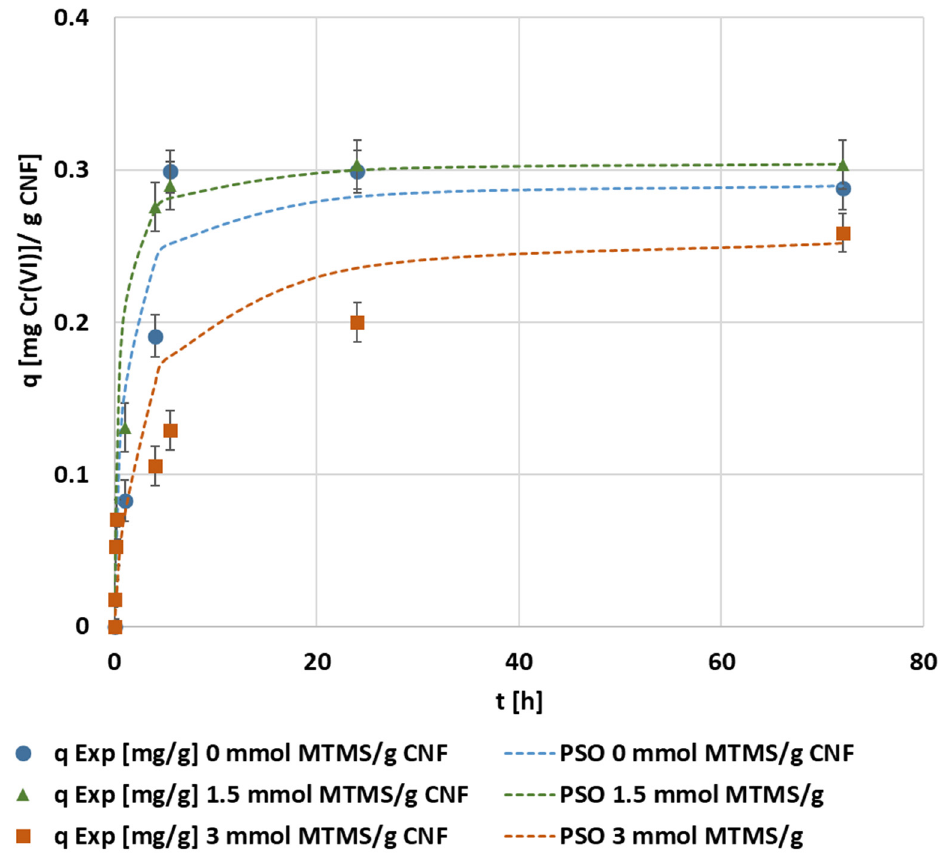
Figure 3. The evolution of the kinetic adsorption experiment at the previously indicated conditions under different MTMS dosages and kinetic fitting of the pseudo-second order model.